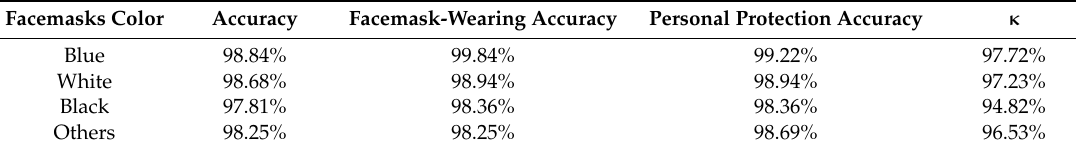
Table 8. Identification result of SRCNet in different colors of facemasks. Facemasks Color